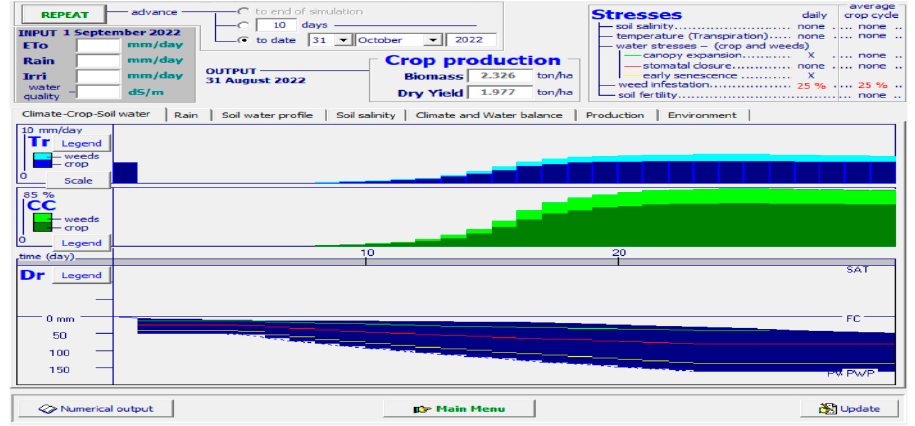
Figure 12. AquaCrop simulator results when fed with the conditions of romaine lettuce cultivated in soil.